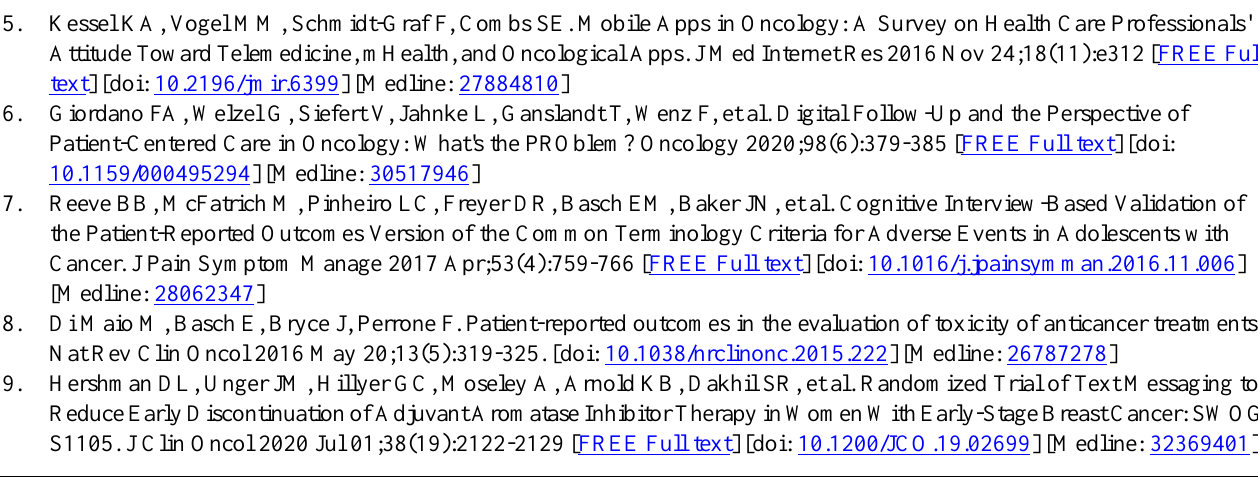
CTCAE: Common Terminology Criteria for Adverse Events ePRO: electronic patient-reported